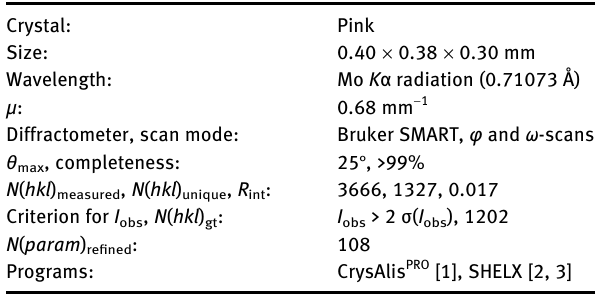
Table  : Data collection and handling. Crystal: